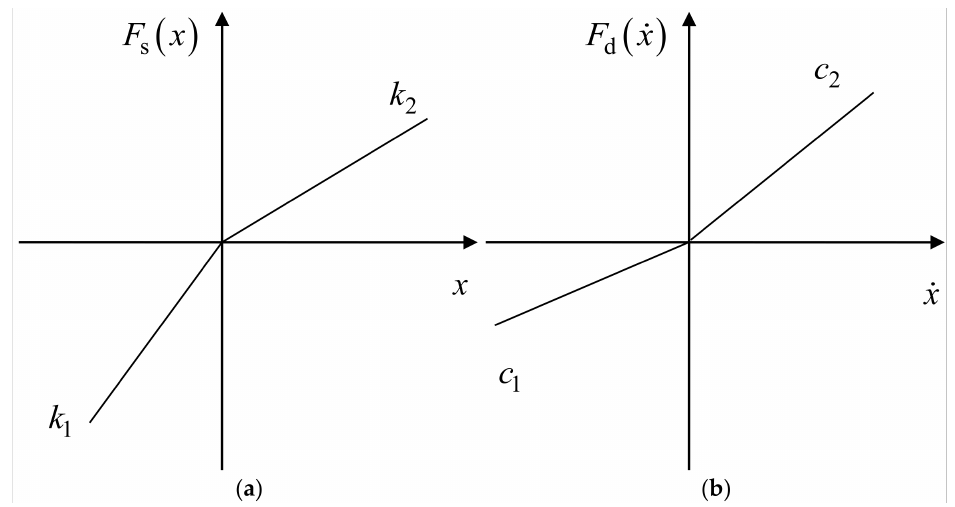
Figure 1. Asymmetrical PWL: ( a ) stiffness characteristics; ( b ) damping characteristics.